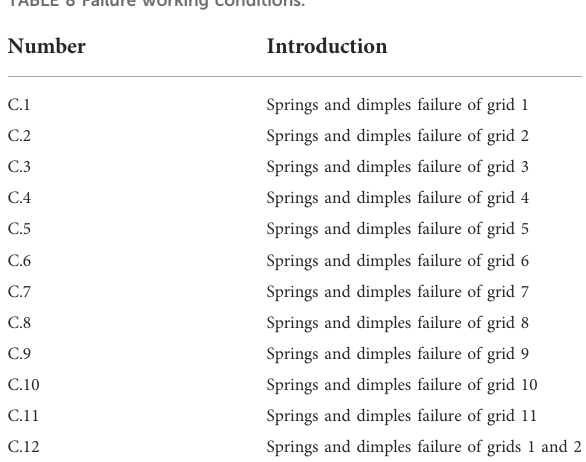
FIGURE 13 Transverse vibration under different transverse fl ow velocities.